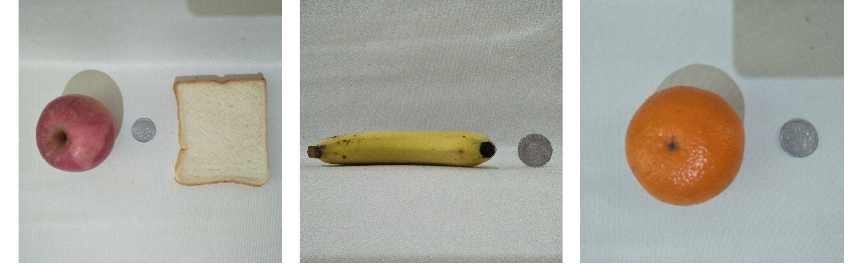
Fig. 2 A few examples of manually collected food pictures with a calibration tool